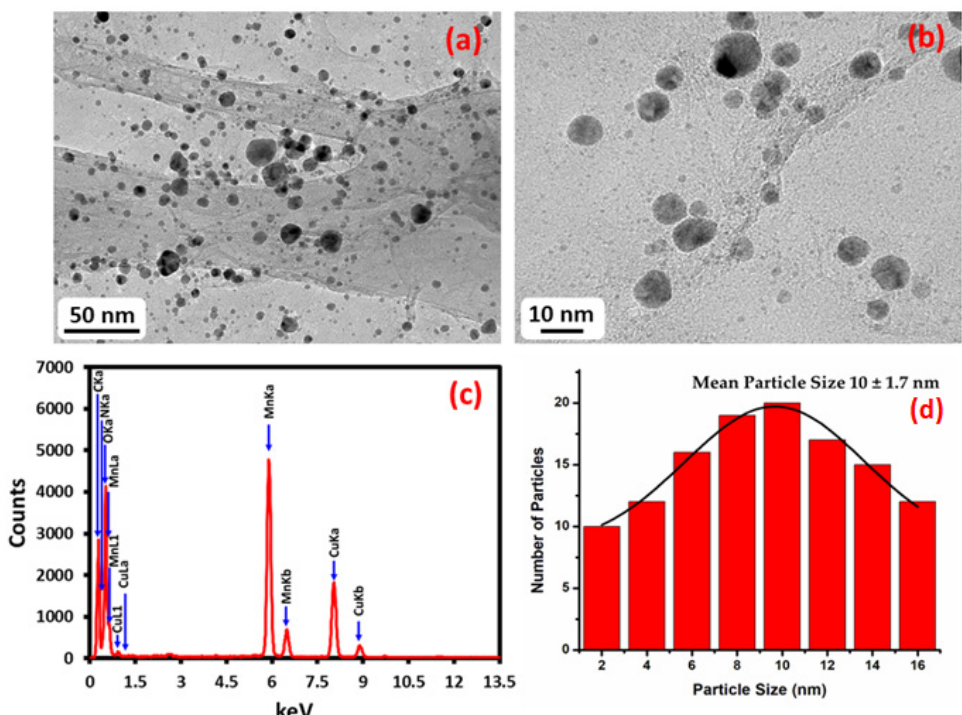
Figure 1. High-resolution transmission electron microscopy (HRTEM) images of the NDG-Mn 3 O 4 nanocomposite ( a ) low magnification image, ( b ) magnified image, ( c ) energy-dispersive X-ray spec- troscopy of NDG-Mn 3 O 4 nanocomposite and ( d ) particle size distribution of NDG-Mn 3 O 4 nanocomposite.